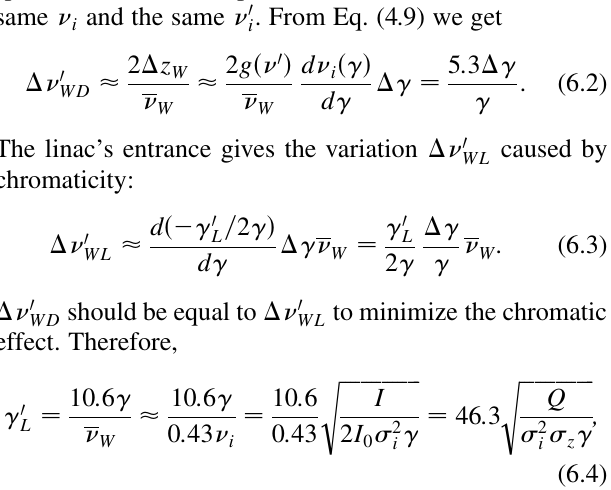
FIG. 12. Schematic layout of the RHIC electron-cooler injector.